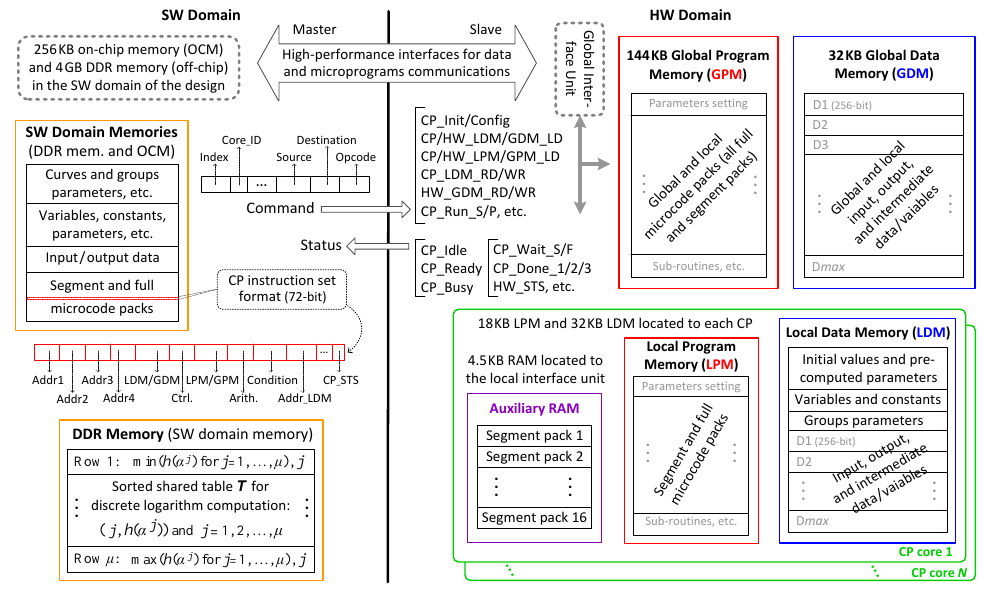
Figure 3: Memory taxonomy and interaction principles of the SW and HW